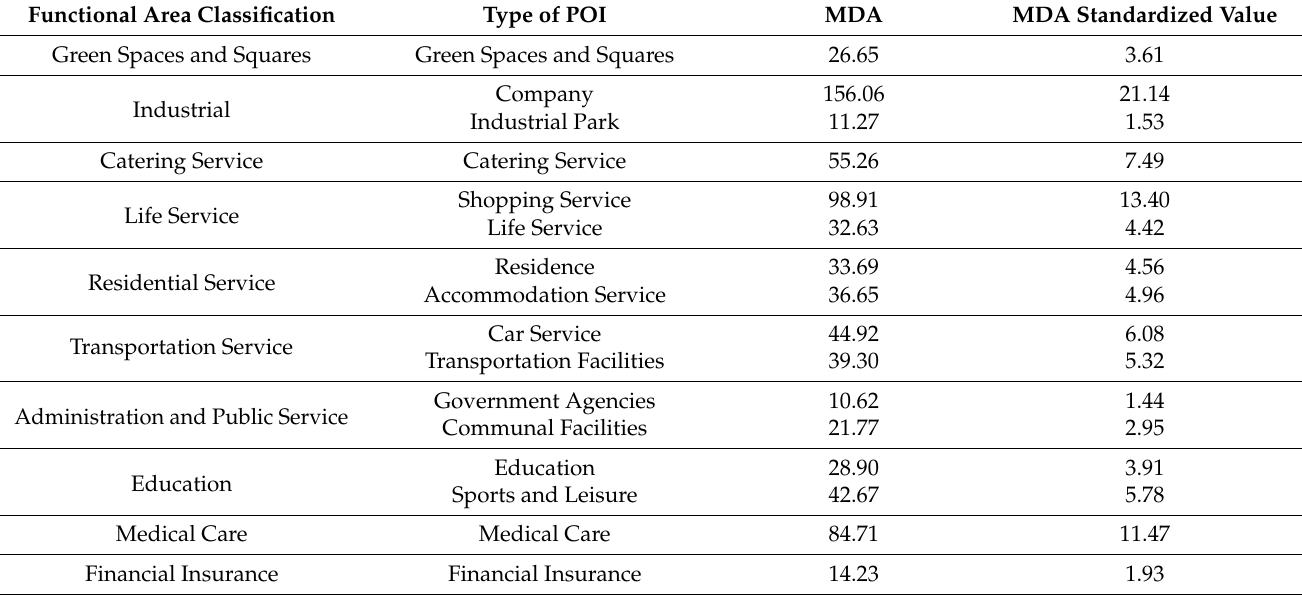
Table 1. Weight index classification table of